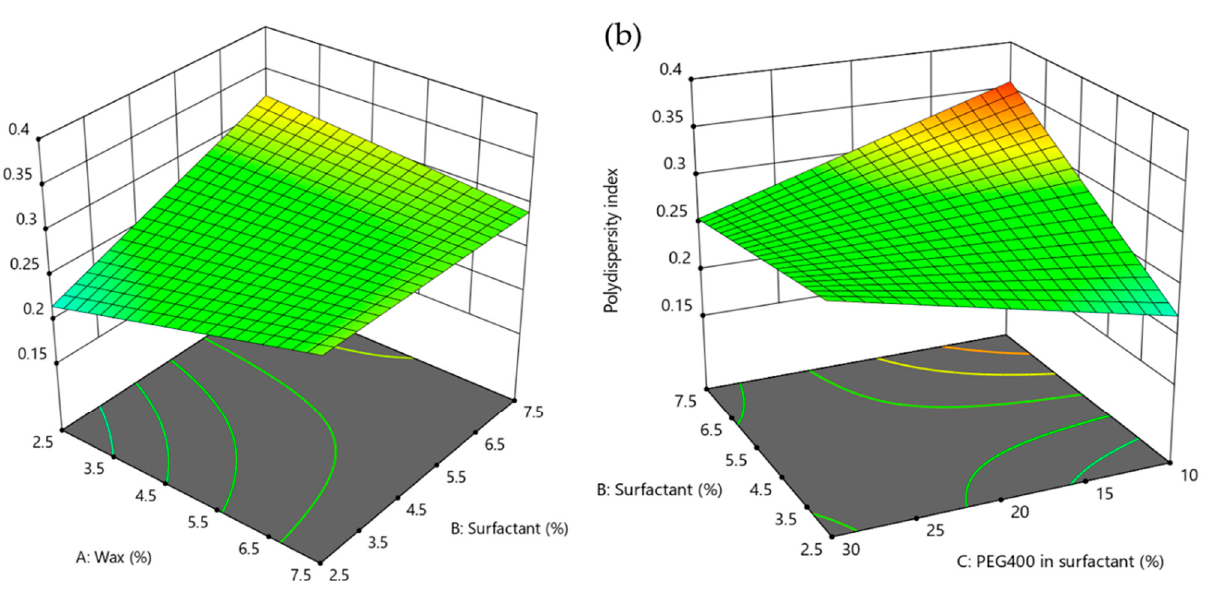
Figure 2. The response surface plot presents the effects of wax, surfactant, and PEG in the surfac- tant on the polydispersity index of SBO-NLCs. ( a ) Interaction of wax and surfactant. ( b ) Interac- tion of surfactant and PEG400 percentage in the